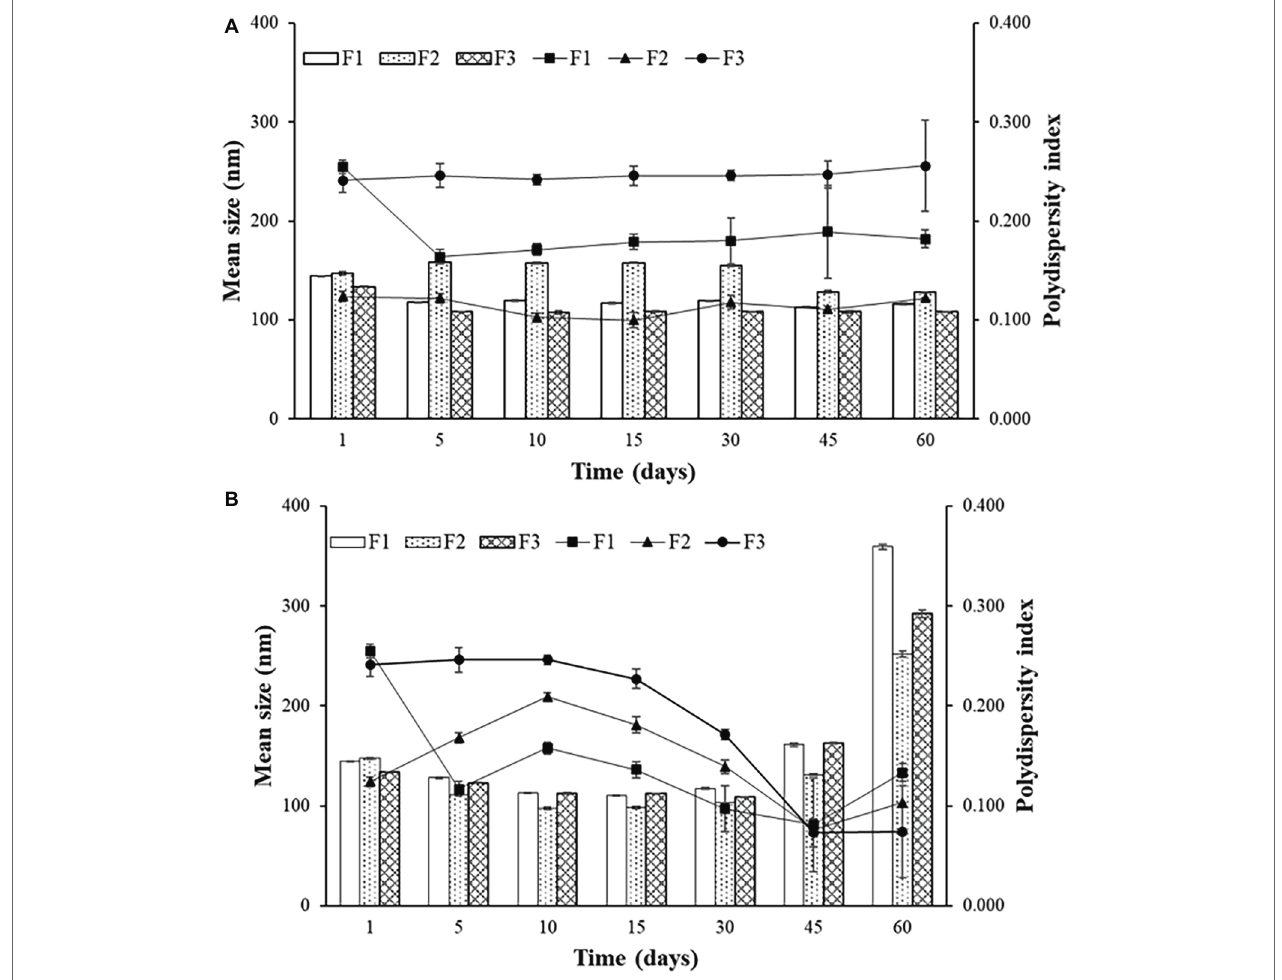
FIGURE 2 | Mean size and polydispersity index (PDI) for F1, F2, and F3 obtained by sonication stored at 4 ° C (A) and at 37 ° C (B)